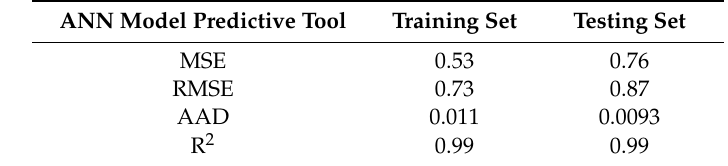
Table 4. ANN model predictive measurements for model fit in the training and testing sets. ANN Model Predictive Tool